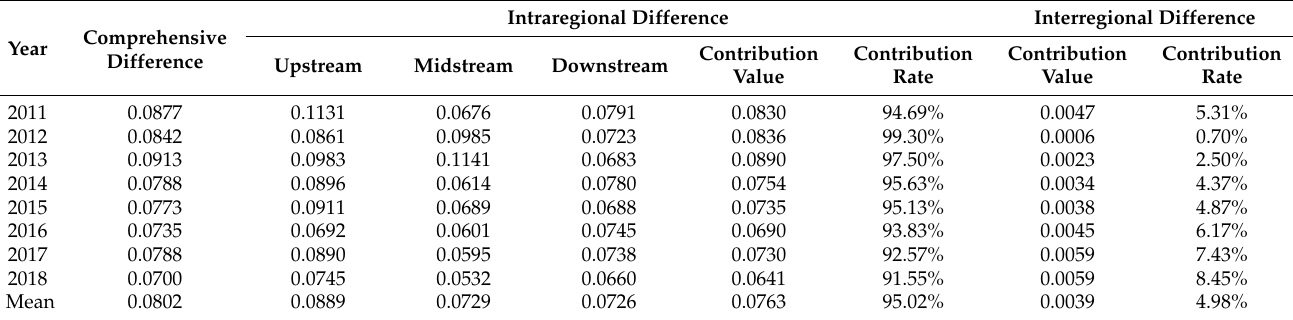
Table 1. Theil index measurement and contribution rate of URI in the YRB from 2011 to 2018. Comprehensive Year Difference Upstream Midstream Downstream